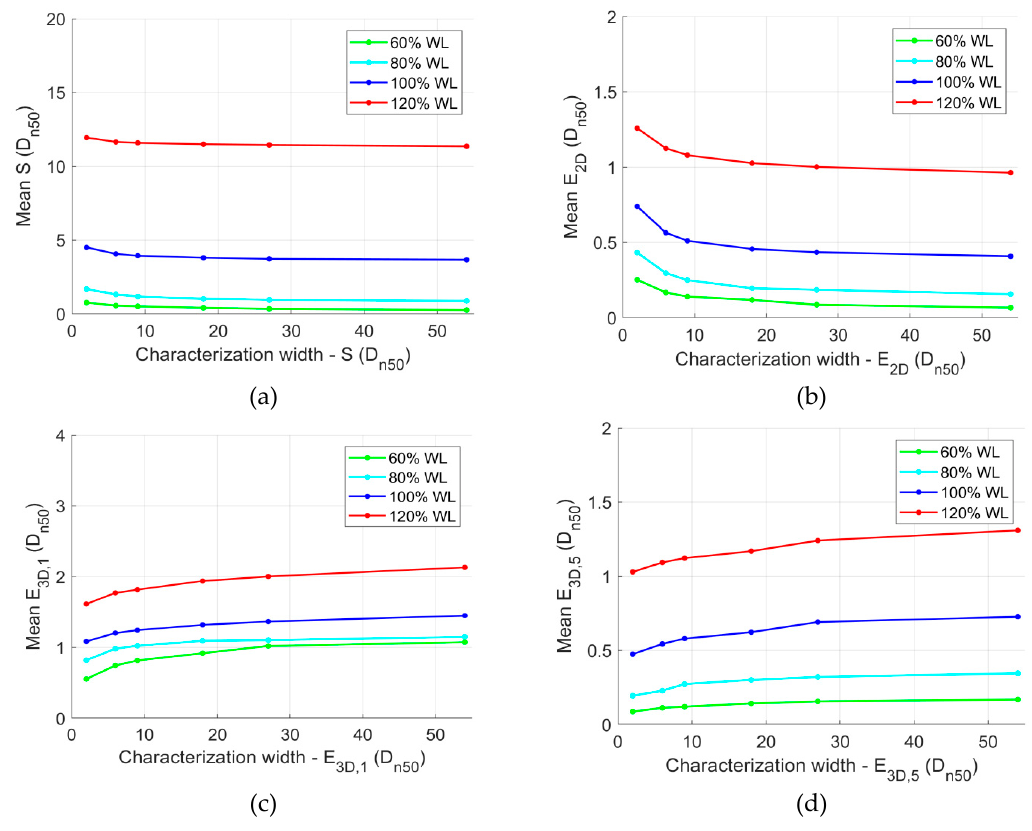
Figure 7. Mean damage values versus the characterisation width, i.e., the width over which the damage is determined (for Series S1); in each panel, another damage parameter was used. ( a ) S parameter; ( b ) E2D parameter; ( c ) E 3D,1 parameter; ( d ) E 3D,5 parameter.